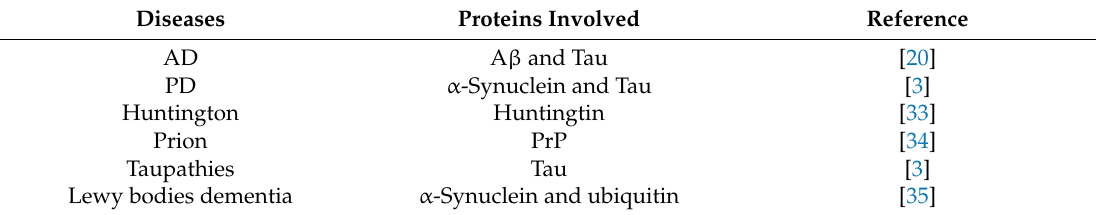
Table 1. Neurodegenerative diseases due to protein misfolding and